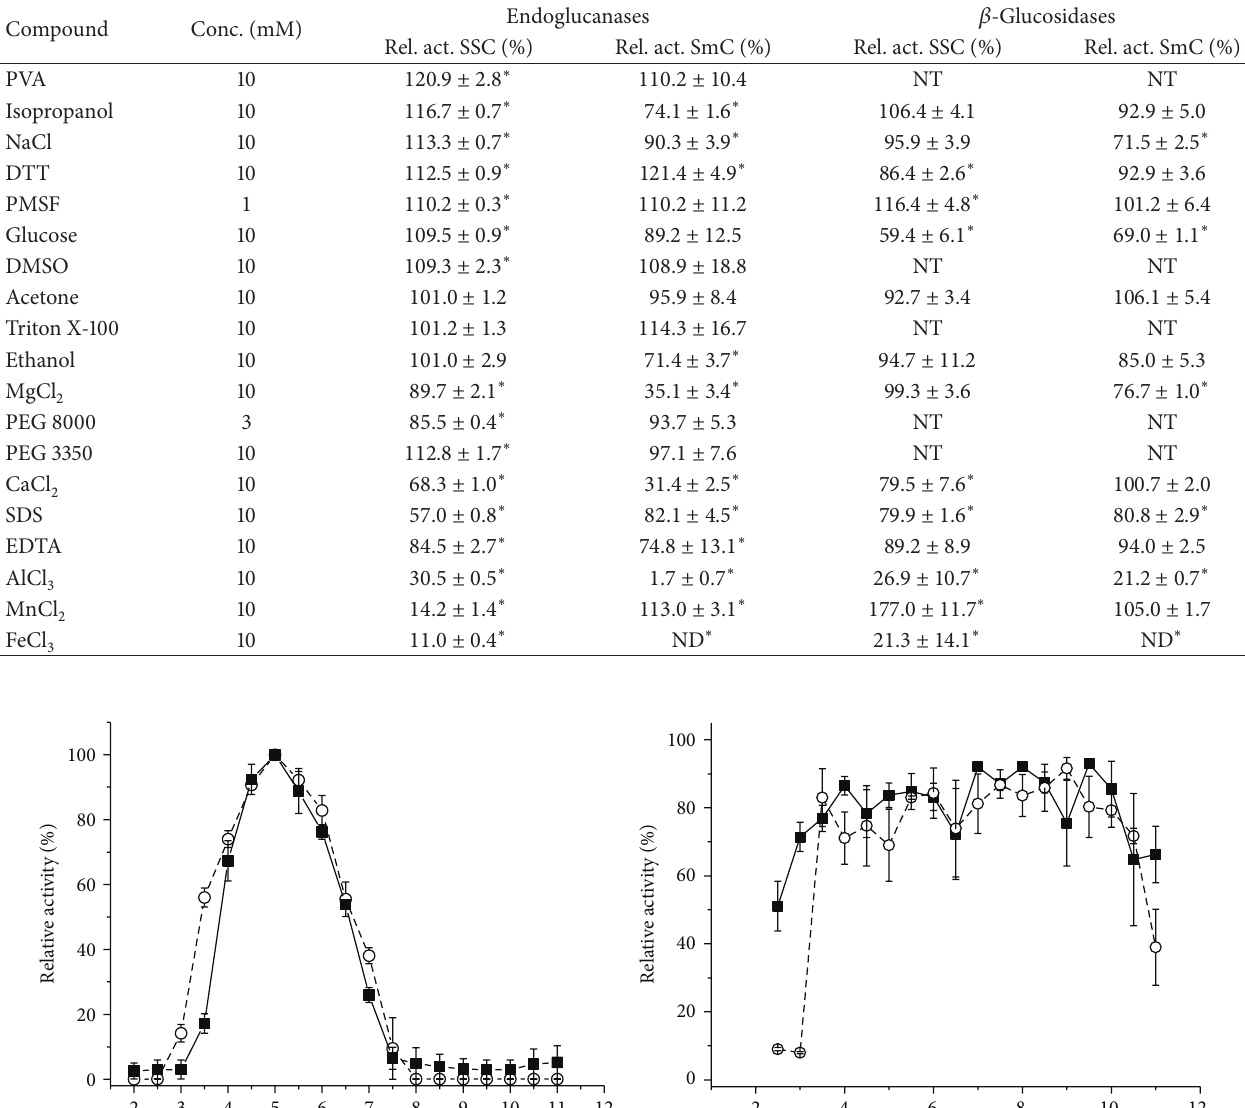
Table 1: Effect of different compounds on endoglucanase and beta-glucosidase relative activity of the dialyzed crude extract expressed as mean values ± SD. NT = not tested; ND = not detected. The asterisks represent significant differences against the control with 𝑝 < 0.05 according to Student’s 𝑡 -test for means.